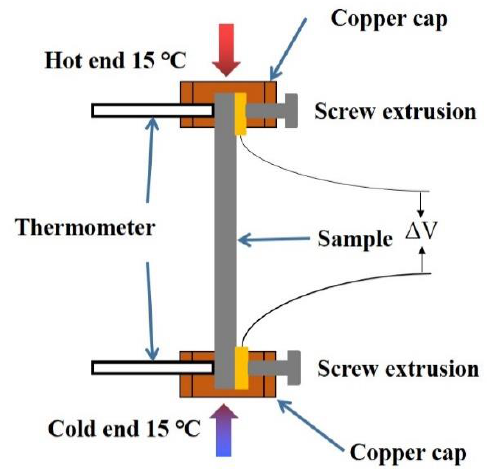
Figure 2. Schematic diagram of TEP measurement.